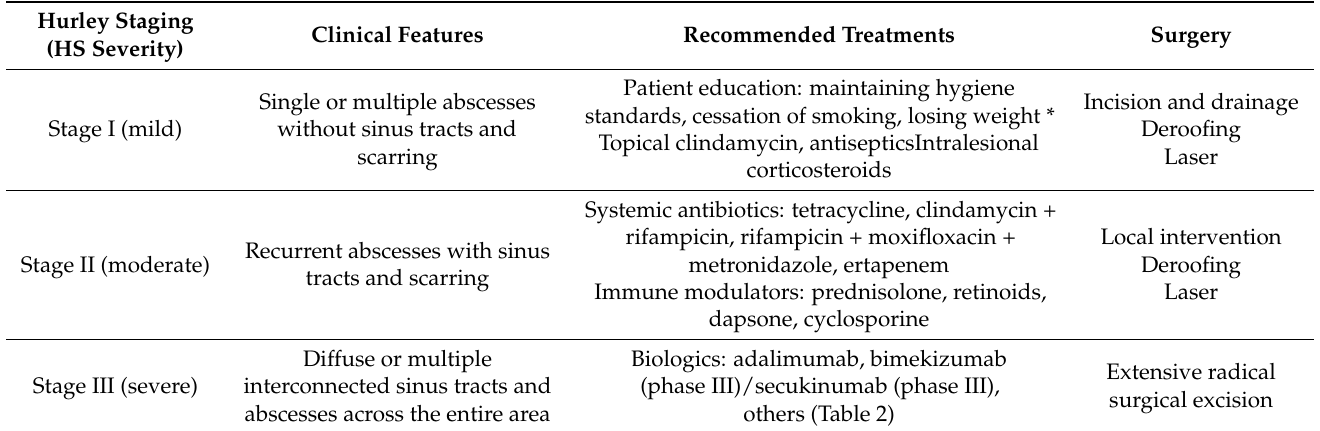
Table 1. Therapeutic approach of